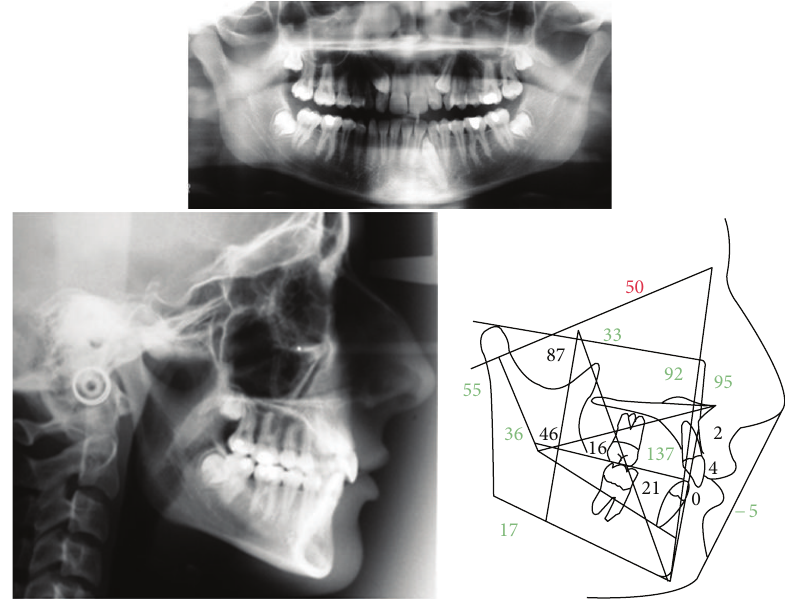
Figure 2: Cephalometric values and panoramic radiograph at the start of treatment.